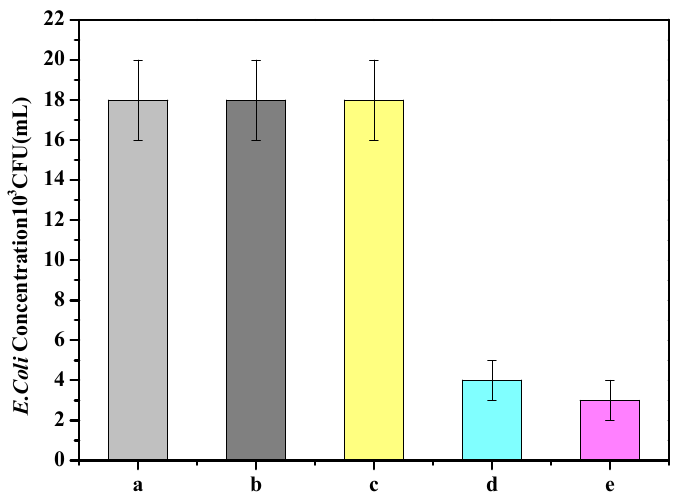
Figure 13. The killing effect of different materials of water processor on E. coli. (a) Without the addition of TiO 2 ; (b) dark conditions; (c) dark conditions after coating; (d) TiO 2 (KH-570)/PLA printing equipment without coating; (e) TiO 2 (KH-570)/PLA printing equipment with coating.